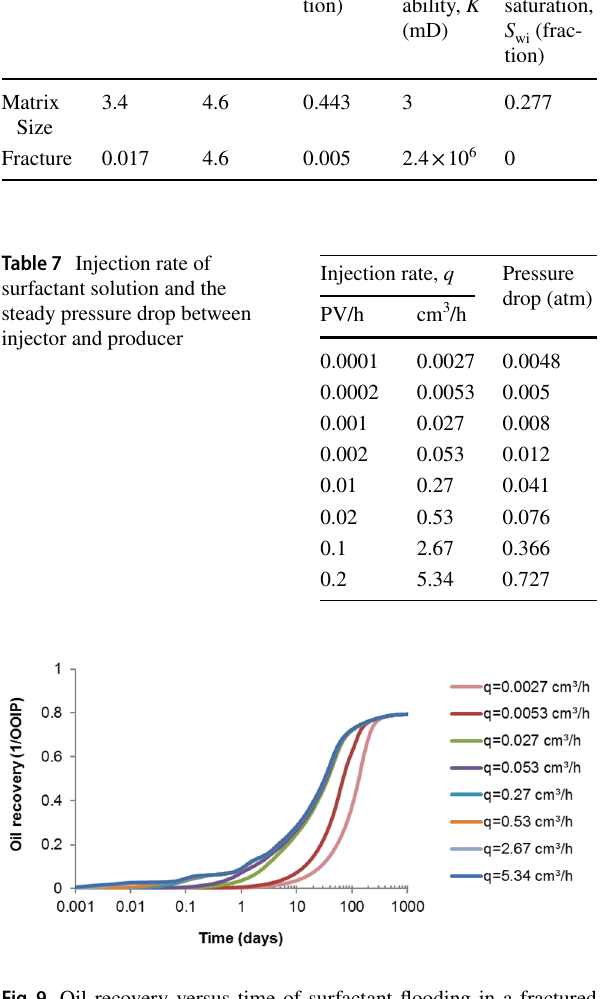
Table 6 Simulation data of the matrix and fracture in the model of fractured matrix Proper- ties